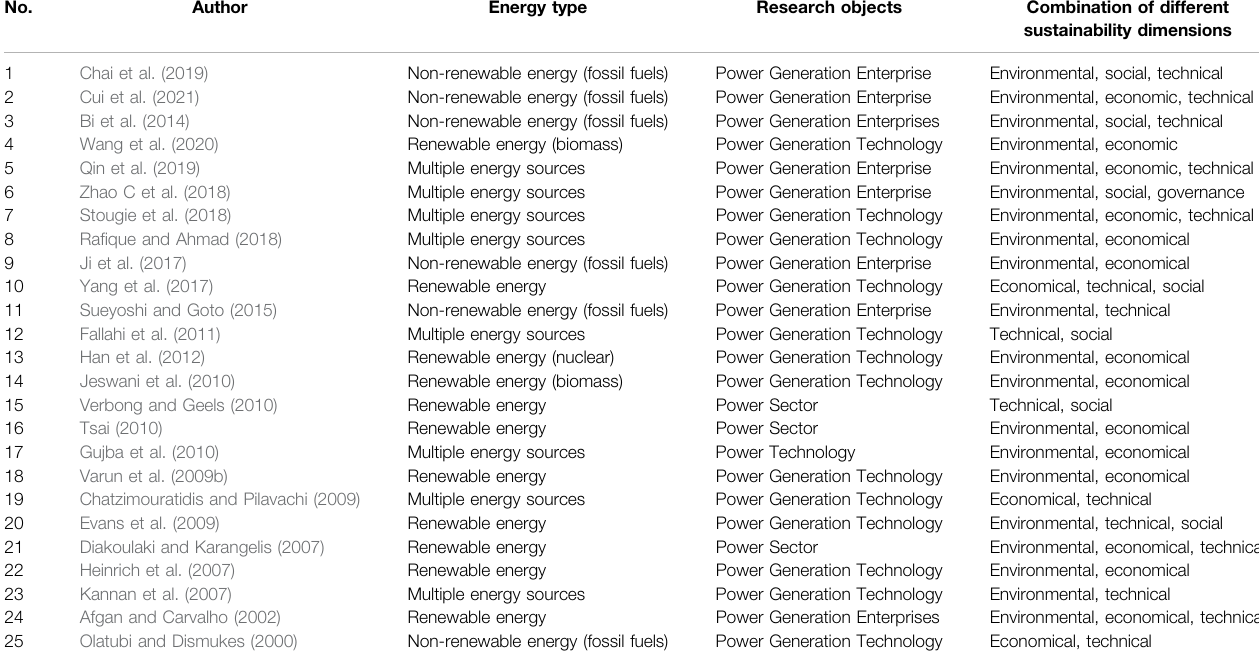
TABLE 6 | Summary of these articles using the Combination of different sustainability dimensions.